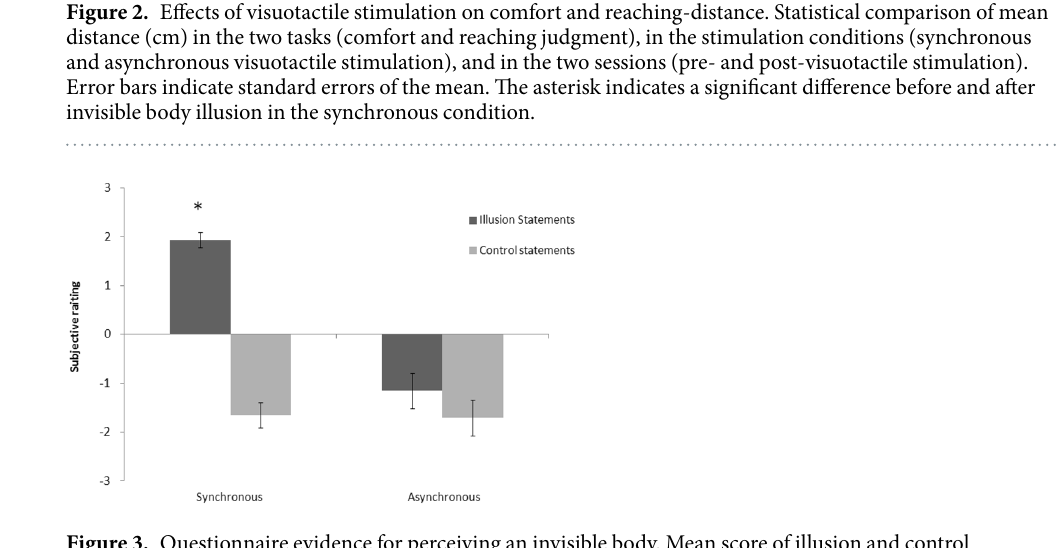
Figure 3. Questionnaire evidence for perceiving an invisible body. Mean score of illusion and control statements as a function of the condition (synchronous and asynchronous). Error bars indicate standard errors of the mean. The asterisk indicates a significant difference between illusion statements in Synchronous condition and all other